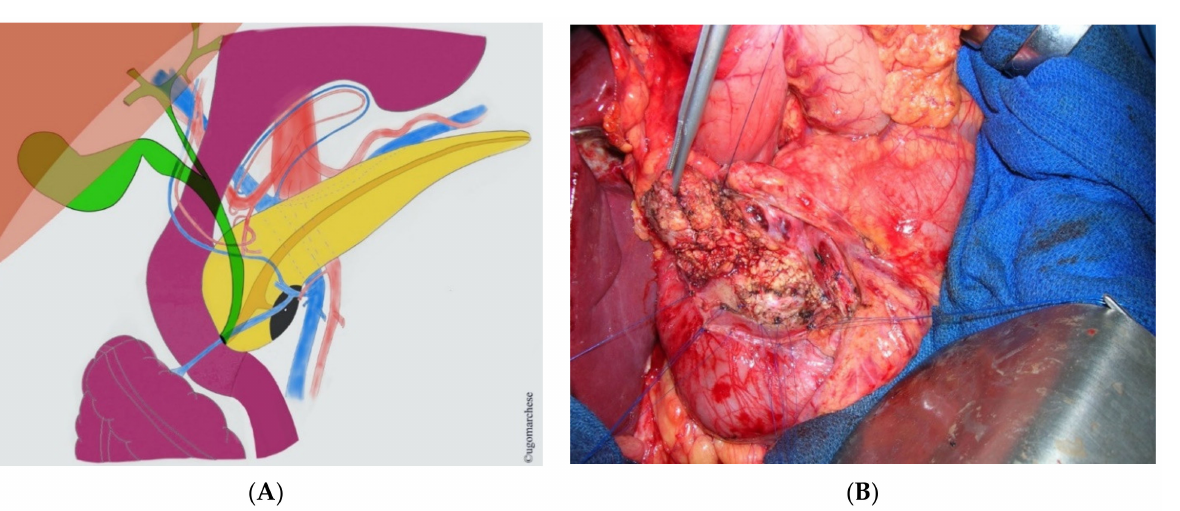
Figure 3. Uncus resection: ( A ) Schema; ( B ) Surgical